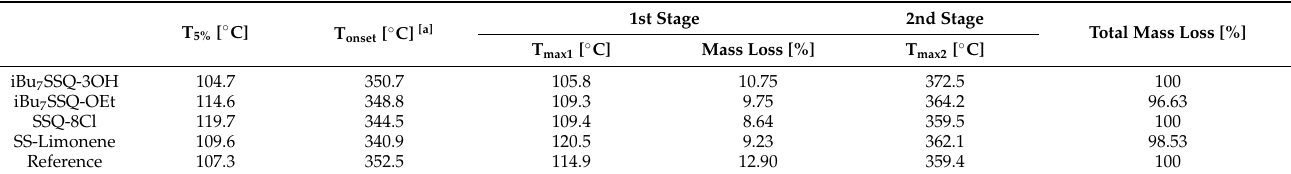
Table 3. Data collected from TGA and DTG curves.